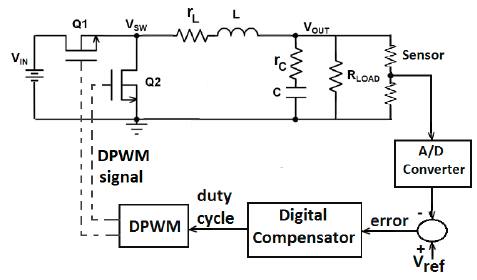
Figure 3. A synchronous buck converters with closed-loop digital control.